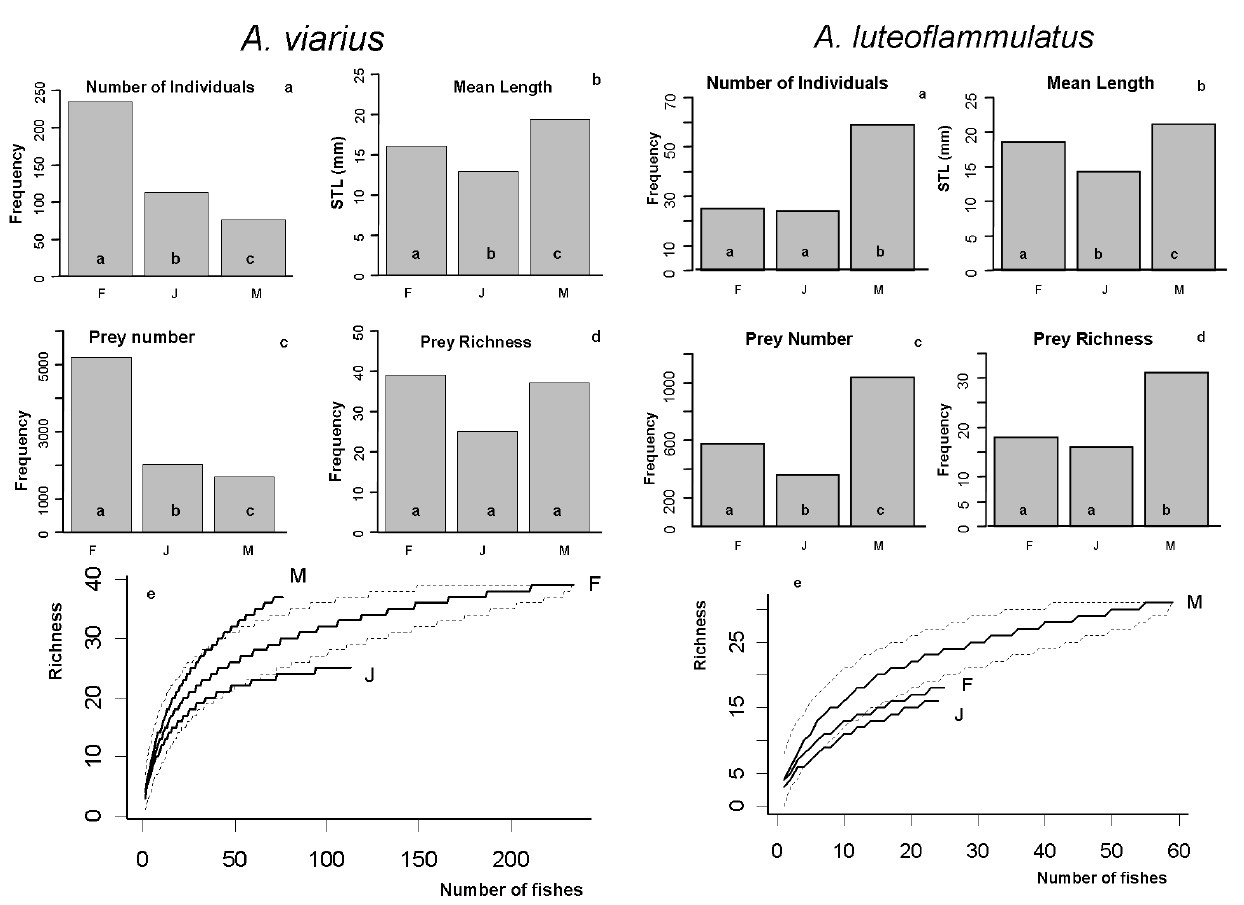
Fig. 2. Sampled fishes of A. viarius and differences between demographic groups (F, J and M) in: (a) number of collected individuals, (b) body sizes measured as STL, (c) total number of prey recorded at gut analysis, and (d) prey richness at the taxonomic level detailed in Table 1. (e) Rarefaction curves for each class. Dashed lines indicate the confident interval at 95%.